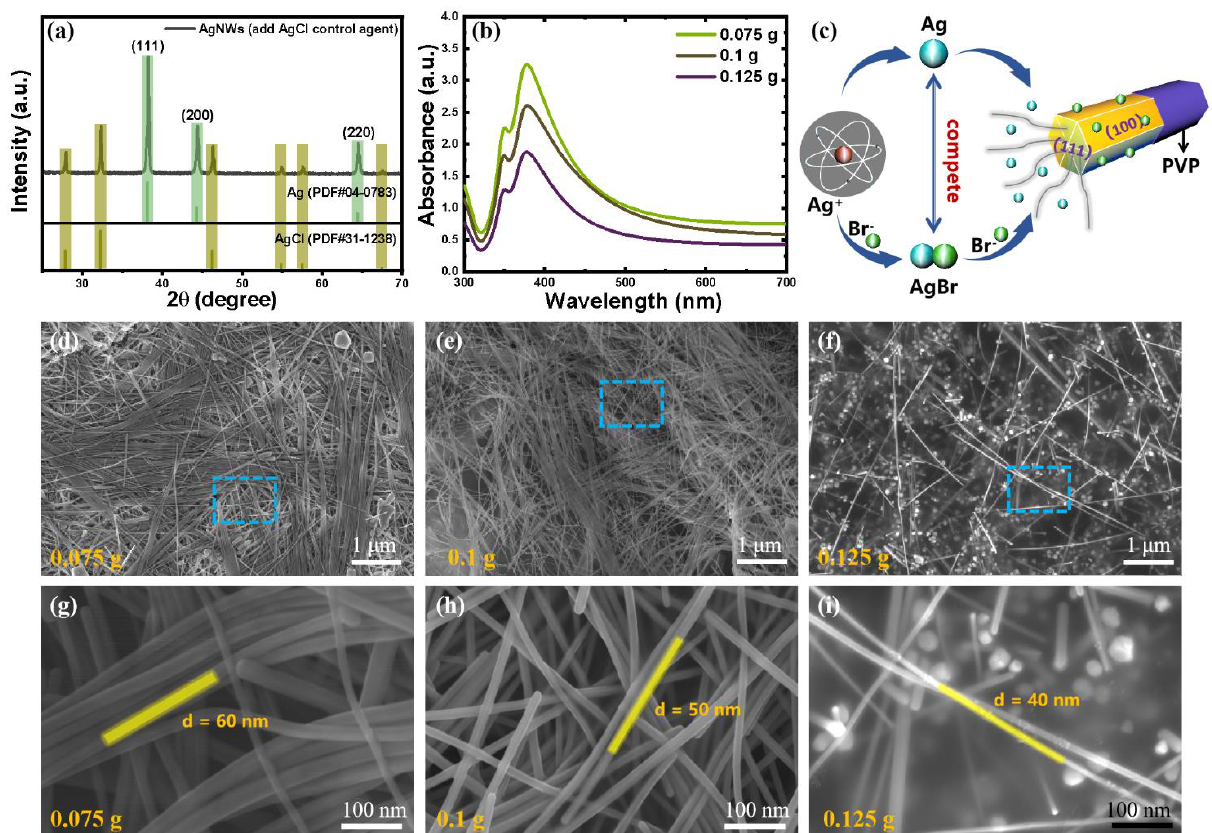
Figure 5. SEM images of AgNWs with different additions of KBr: ( a ) XRD pattern of AgNWs after the addition of AgCl control agent; ( b ) UV – vis absorption spectra of AgNWs with different additions of KBr; ( c ) Schematic diagram of the effect of Br − in the preparation of AgNWs. ( d ) 0.075 g, ( e ) 0.1 g, ( f ) 0.125 g; ( g – i ) are enlarged views of the blue boxes in ( d – f